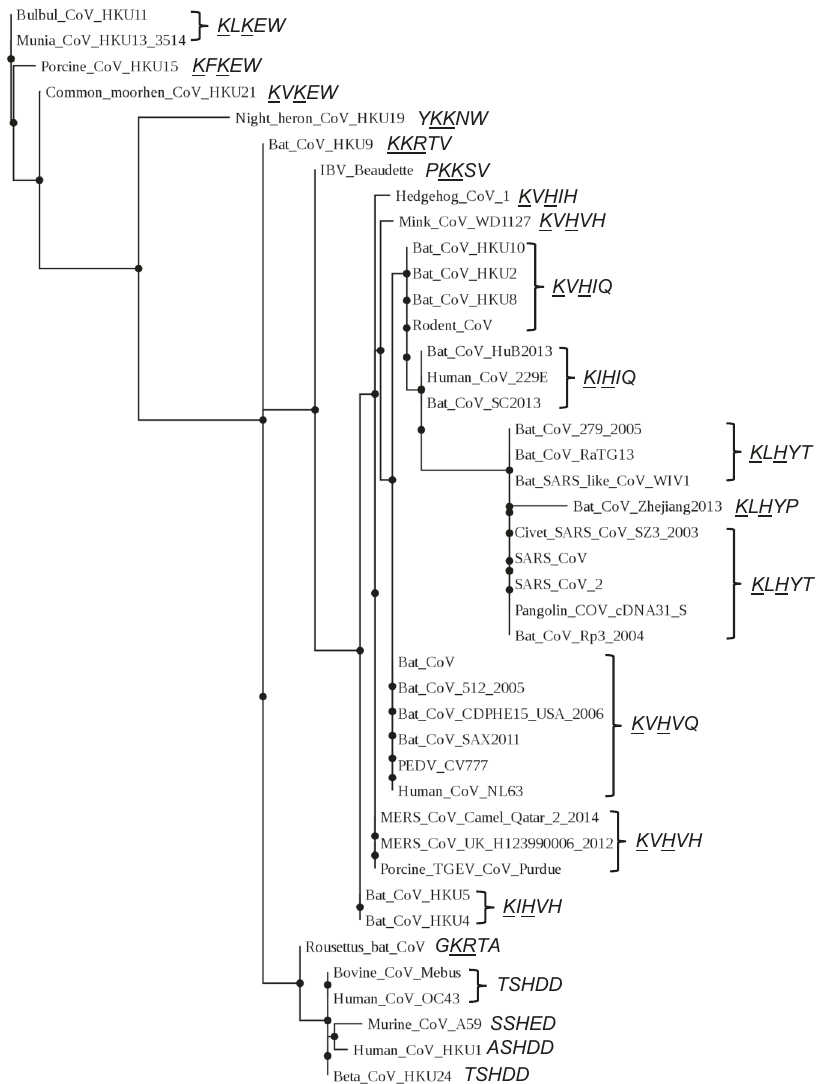
Fig. 5 Phylogenetic analysis of coronavirus spike C-terminal sequence. This phylogram was generated from the alignment of fi ve C-terminal residues in the spike protein. This penta-residue spike sequence is shown in italics to the right of each coronavirus. The residues in the dibasic motif are underlined. An acidic Asp is seen at the C-terminus of the spike proteins of only those coronaviruses that lack a dibasic